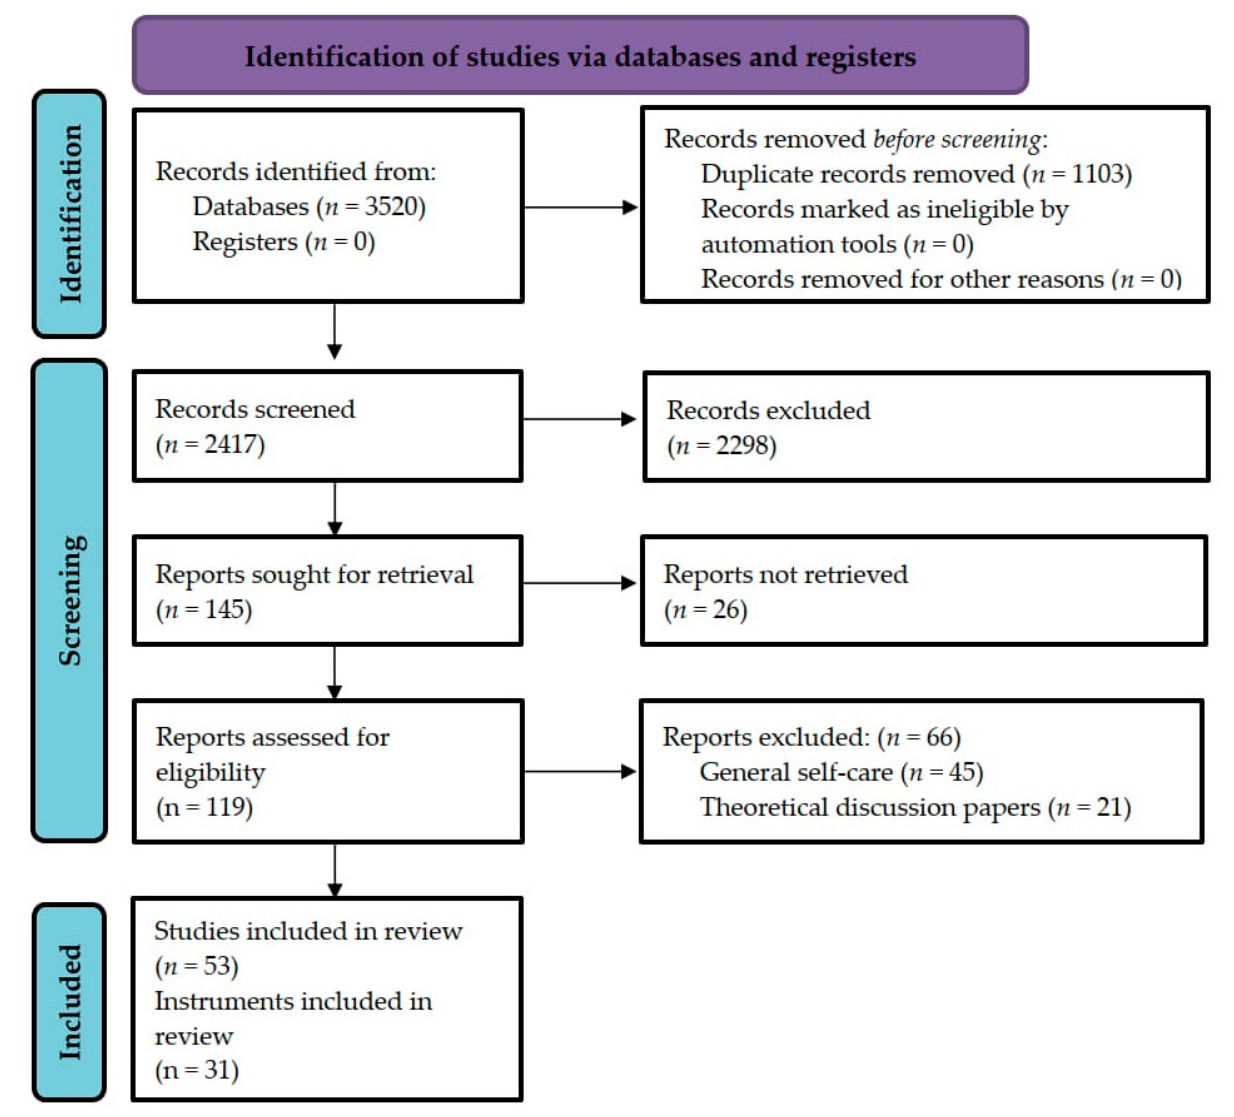
Figure 1. Flowchart of the study selection process.